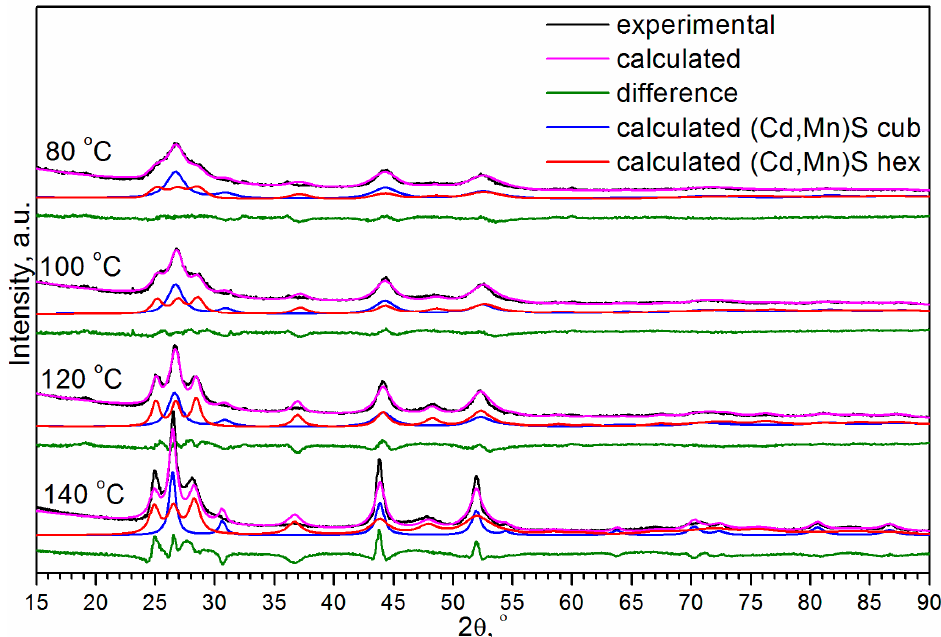
Figure 3. Rietveld analysis of experimental XRD patterns of (Cd,Mn)S as main compound of samples prepared by HTS at different temperatures.